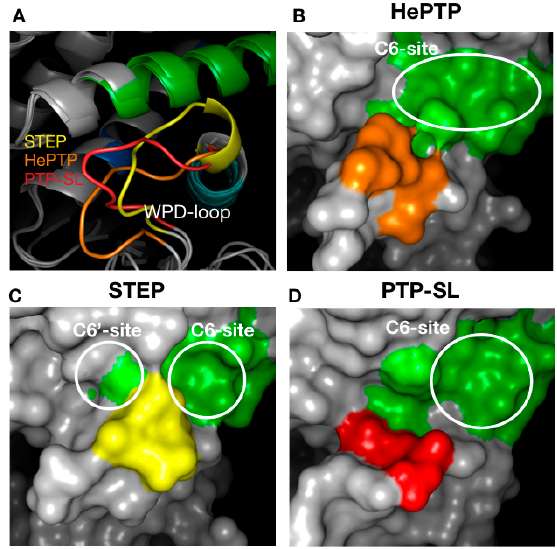
Figure 5. Structural analysis of the pocket associated with cluster 6 across the three KIM-PTPs (HePTP, PTPSL and STEP). ( A ) Different conformations of the WPD loop across the KIM-PTPs are shown in cartoon format. ( B – D ) The effect of the position of WPD-loop on the size and shape of the pocket associated with cluster 6 is shown, with the three KIM-PTPs being represented as surfaces. The colouring is as follows: the K8 motif is green, whilst the WPD loop is coloured orange (HePTP), yellow (STEP), and red (PTP-SL).